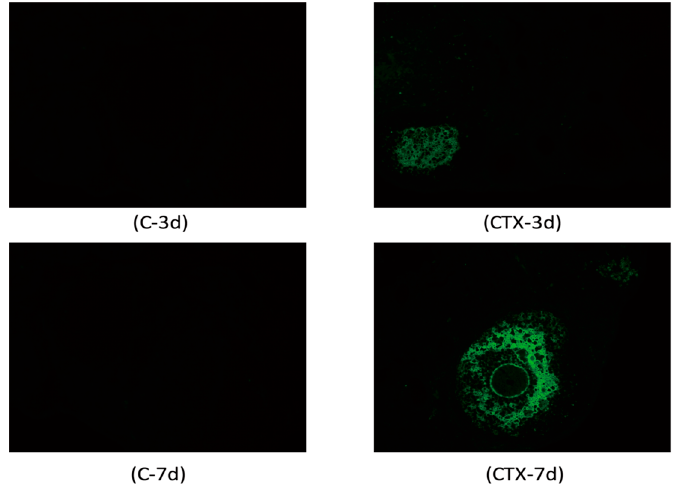
Figure 3. Cyclophosphamide accelerated growing follicle apoptosis: representative images of TUNEL staining for follicle cell apoptosis on ovaries. Green fluorescence indicates apoptotic follicle cells (original magnification 200×).